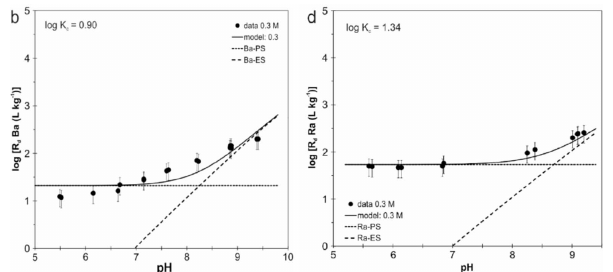
Fig. 2. Experimental and modelling results for pH-dependent sorption edges of Ba (left, b) and 226 Ra (right, d) on Na-SWy-2 in 0.3 M NaCl background electrolyte. Ra/Ba-PS = planar sites; Ra/Ba-ES = edge sites (modified after Klinkenberg et al. [2]).